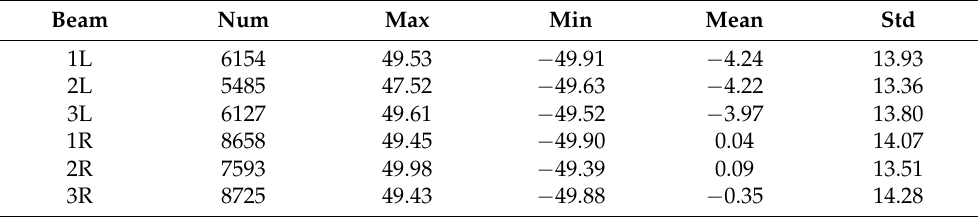
Table 5. Differences in SSHs at the self-crossover points of ICESat-2 without time limit (Unit: cm).